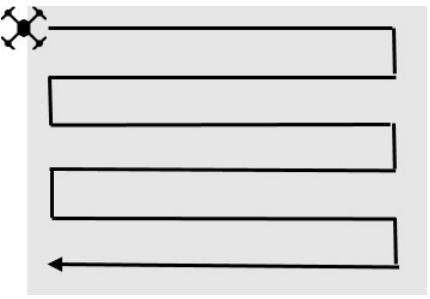
Figure 6. Schematic diagram of a plot sampling method using UAV.